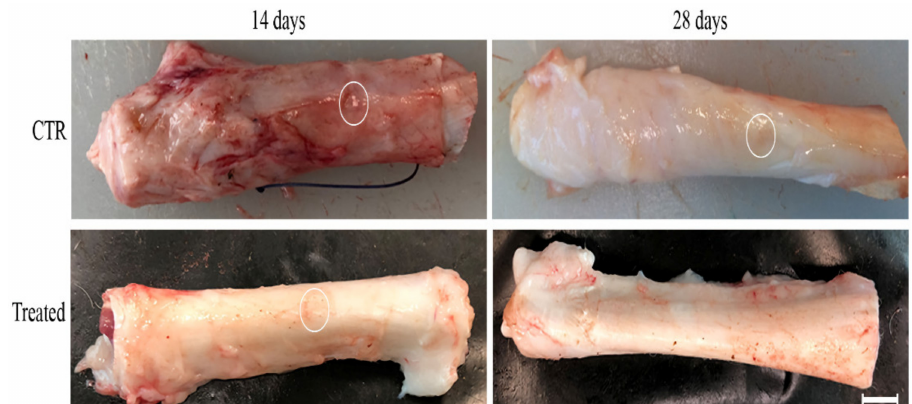
Figure 3. Macroscopic morphology of the explanted ovine Achilles tendons at day 14 and 28. Representative images of healthy, CTR, and treated Achilles tendons explanted after 14- and 28-day treatments. The 5 mm circular defects created in the ovine Achilles tendons are evidenced within the white circle; in treated tendons explanted at 28 days the defect is not distinguishable anymore. CTR tendons were filled with fibrin glue, whereas the treated tendons with 1 × 10 7 PKH26-stained eAECs, mAECs, or tdAECs cells suspended in fibrin glue. Scale bar = 0.3